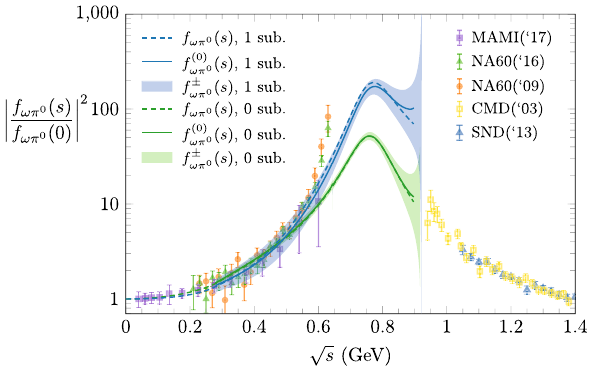
Fig. 11 Normalized ωπ 0 TFF, | f ωπ 0 ( s )/ f ωπ 0 ( 0 ) | 2 . The experimen- tal points are taken from Refs. [36–38,80,81]. The green (blue) lines representthecaseinwhichtheunsubtracted(oncesubtracted)KTequa- tions are used for the ω → 3 π amplitude. The dashed lines represent the value of the TFF from a subtracted DR, Eq. (2.28). The solid lines ( 0 ) ( s ) , Eq. (3.6a), whereas represent the central value of the bounds f ωπ 0 the band represent the bounds, Eq. (3.5). The values I = 4 . 63 GeV − 4 (from Ref. [30]) and I th = 33 GeV − 4 are used in the unsubtracted and once subtracted case calculations of the bounds,